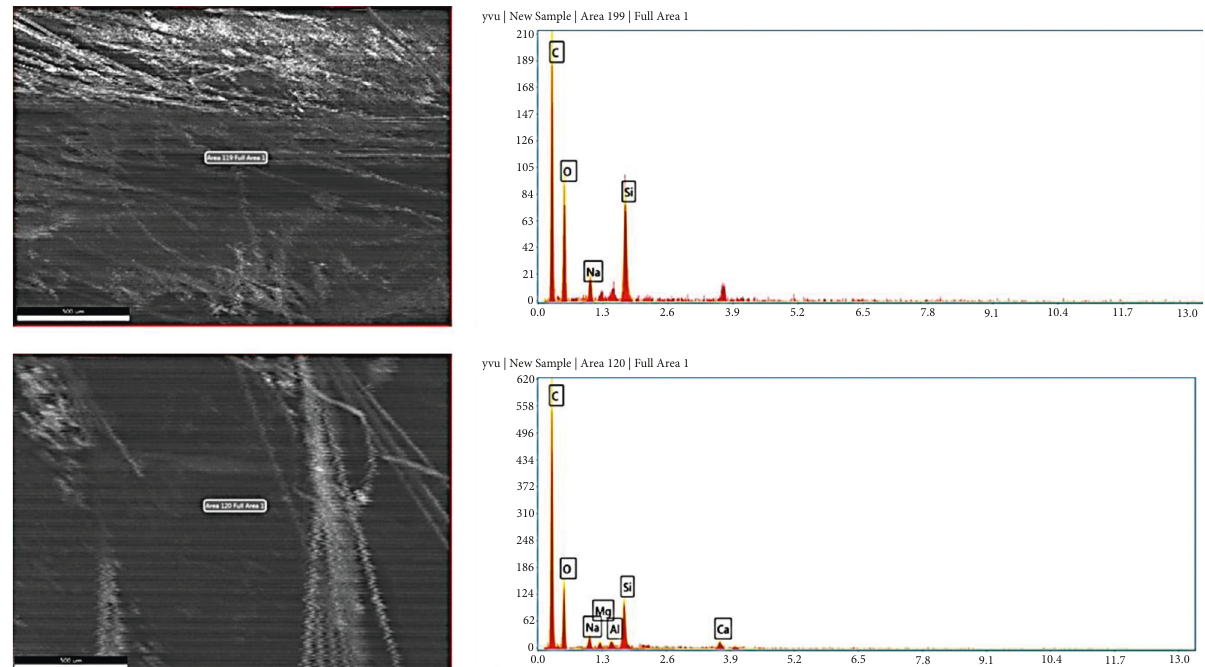
Figure 10: EDS of solid jet abrasion test micro carbon powder-filled GFRP.